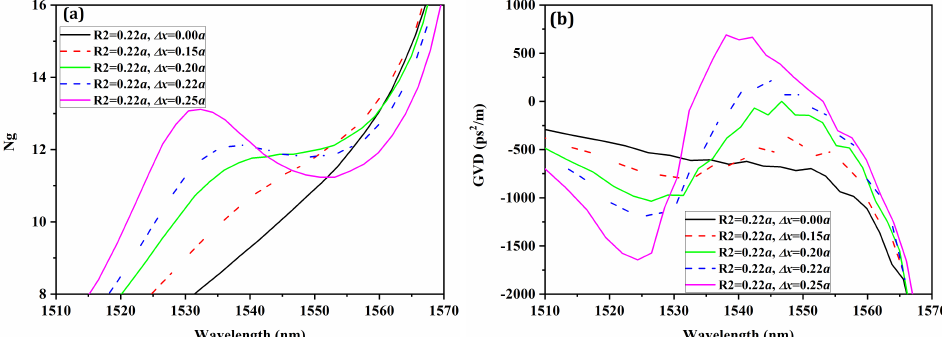
Figure 6. ( a ) The calculated group index and ( b ) Calculated GVD parameters, where R2 = 0.22 a and a is equal to 380